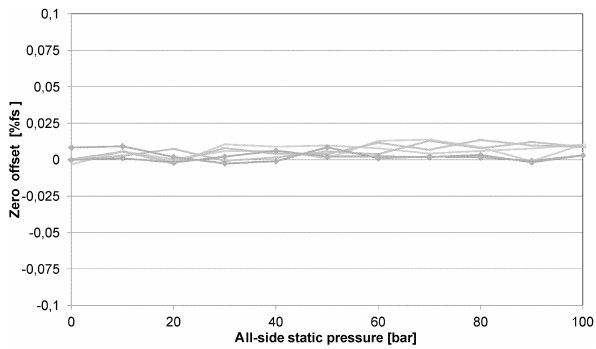
Figure 11. Dependency of the zero offset from static pressures.